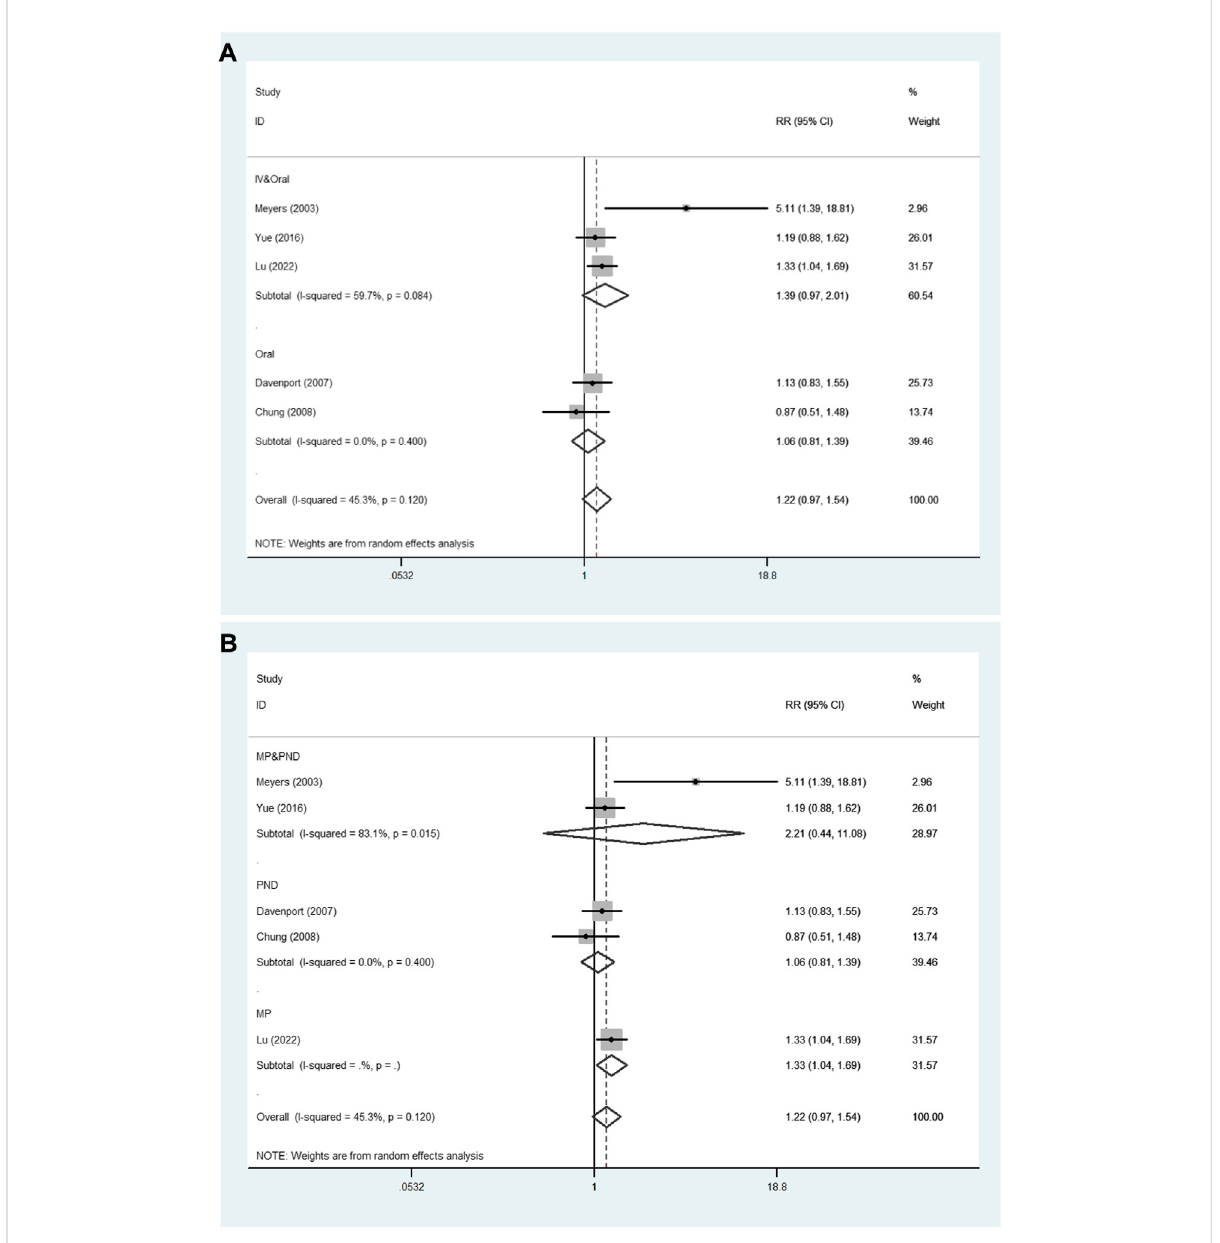
FIGURE 6 The subgroup analysesfor theassessment of NLSRat 12 months. (A) Administration method. (B) Steroid type. NLSR, native liversurvival rate;IV, intravenous; MP, methylprednisolone; PND,